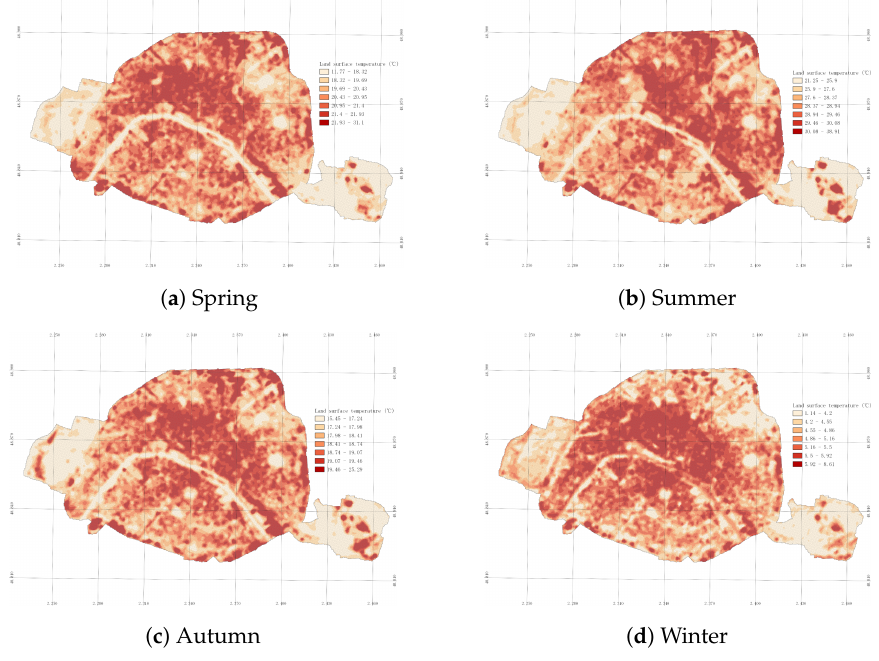
Figure 5. Mean Land Surface Temperature ( ◦ C) of four seasons in Paris.